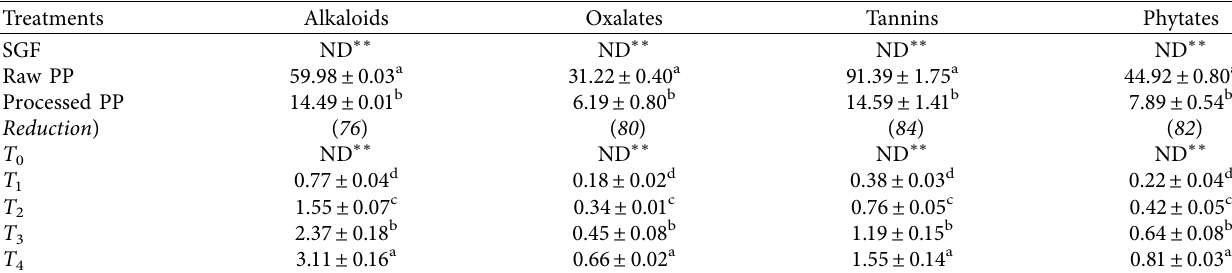
Values are means ± S.D. ( n � 2). Values having identical lettering in each column are nonsignificant at p > 0 . 05. T 0 � 100% straight-grade wheat flour chapatis (control), T